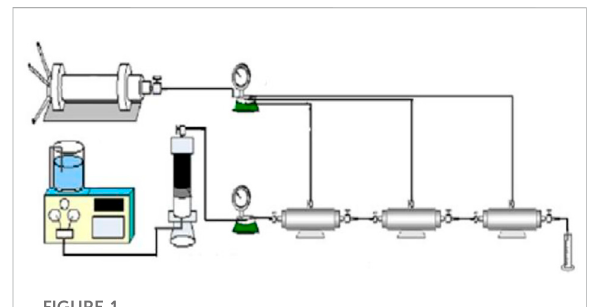
FIGURE 1 Core-scale experimental device for tight oil